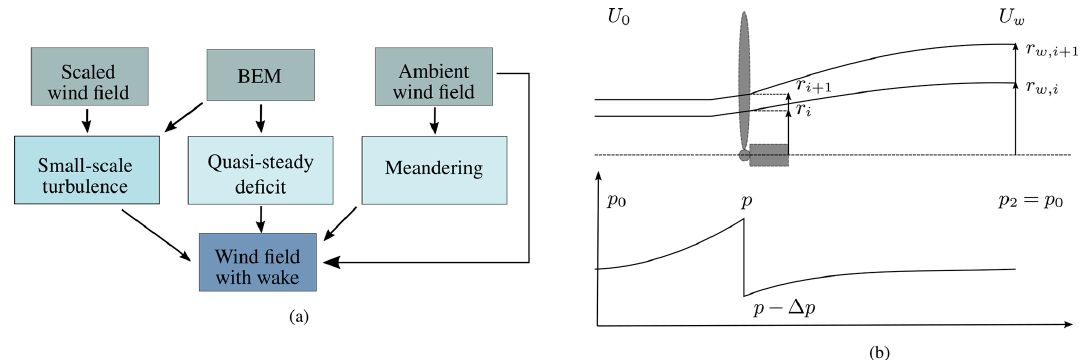
Figure 7. Components of the DWM model (a) (Reinwardt et al., 2018) and schematic illustration of the wake expansion in the DWM model (b) according to Madsen et al.